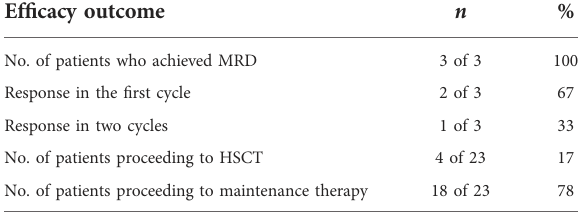
TABLE 2 Ef fi cacy outcomes of 23 patients with